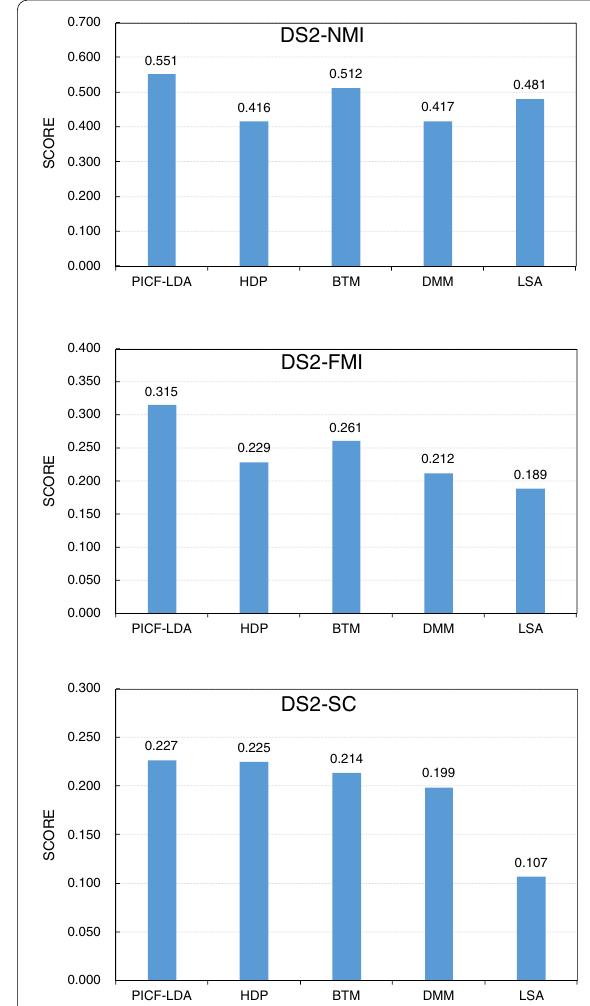
Fig. 10 Performance comparison between PICF-LDA and non-LDA models in